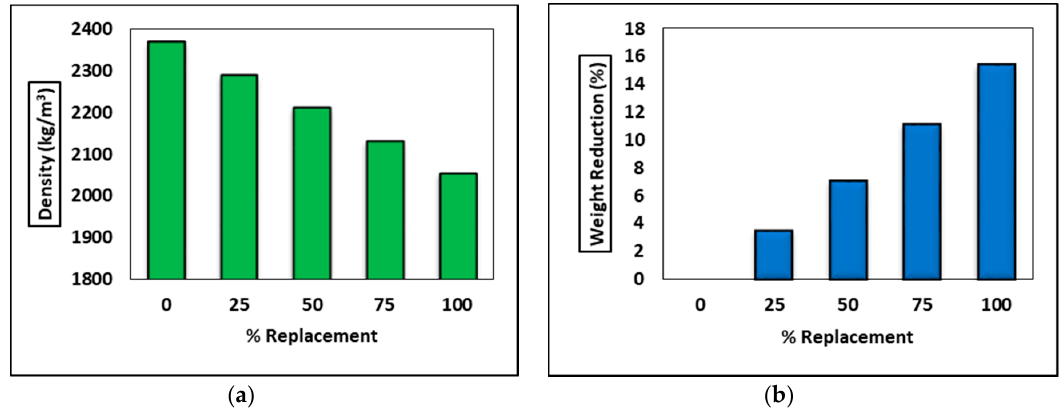
Figure 4. % replacement of carbon black. ( a ) Effect on density, ( b ) effect on weight reduction.